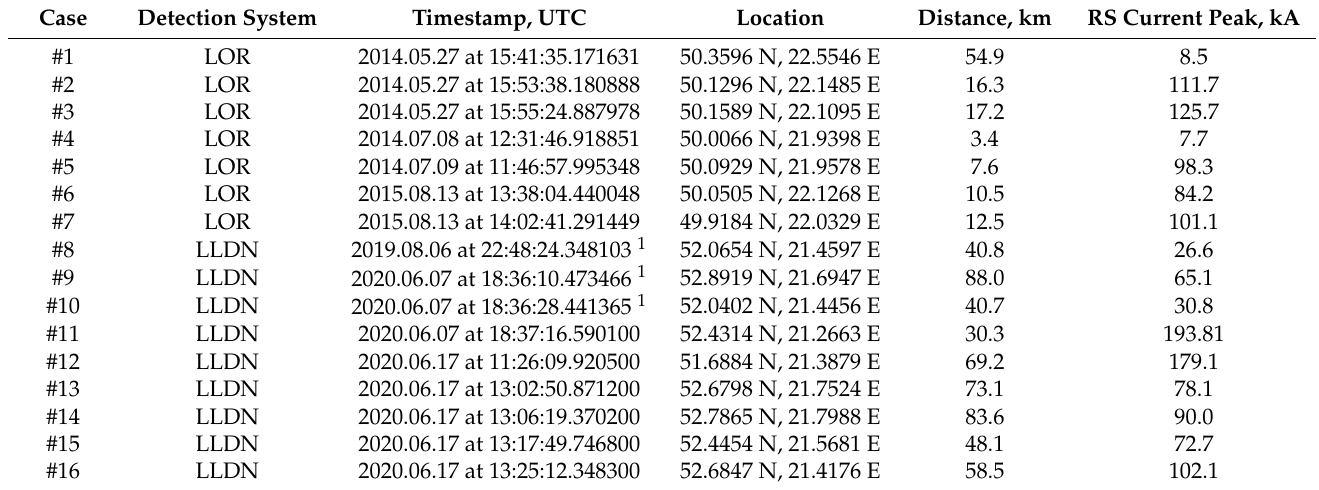
Table 1. Positive CG flash incidents selected from Rzeszow (LOR) and Warsaw (LLDN) lightning databases. The distances were obtained from the LINET system for the LOR and from the PERUN system for the